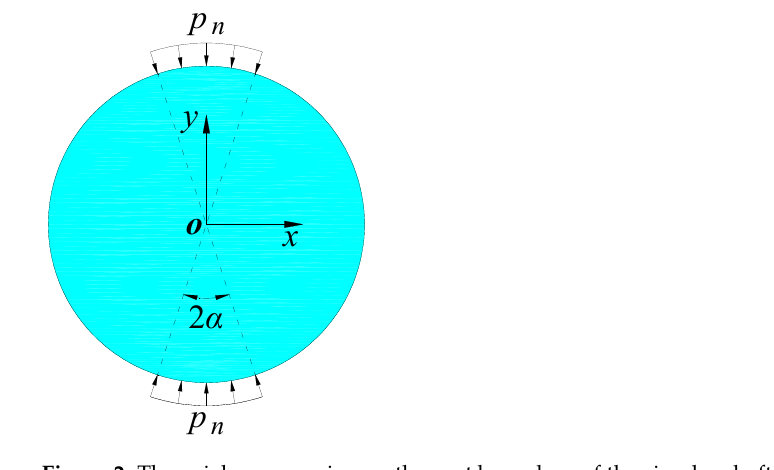
S ( r = 1.4) is evenly divided. The number of virtual elements and the number of virtual nodes are identical. Virtual nodes are positioned at the midpoint of their virtual elements. Figure 2. The axial compression on the part boundary of the circular shaft.